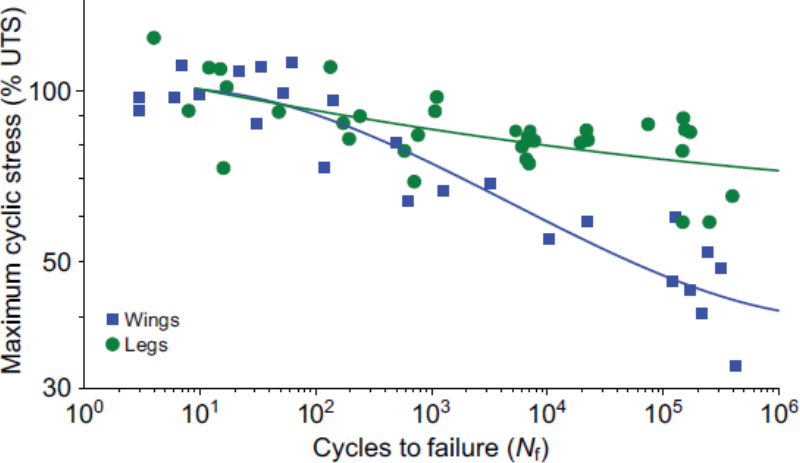
Figure 3: Stress-life fatigue data for insect legs and wings.